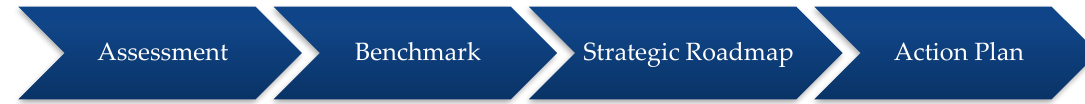
Figure 5. Analytics Maturity Assessment framework (Blast Model). Source: own elaboration based on Blast Model.